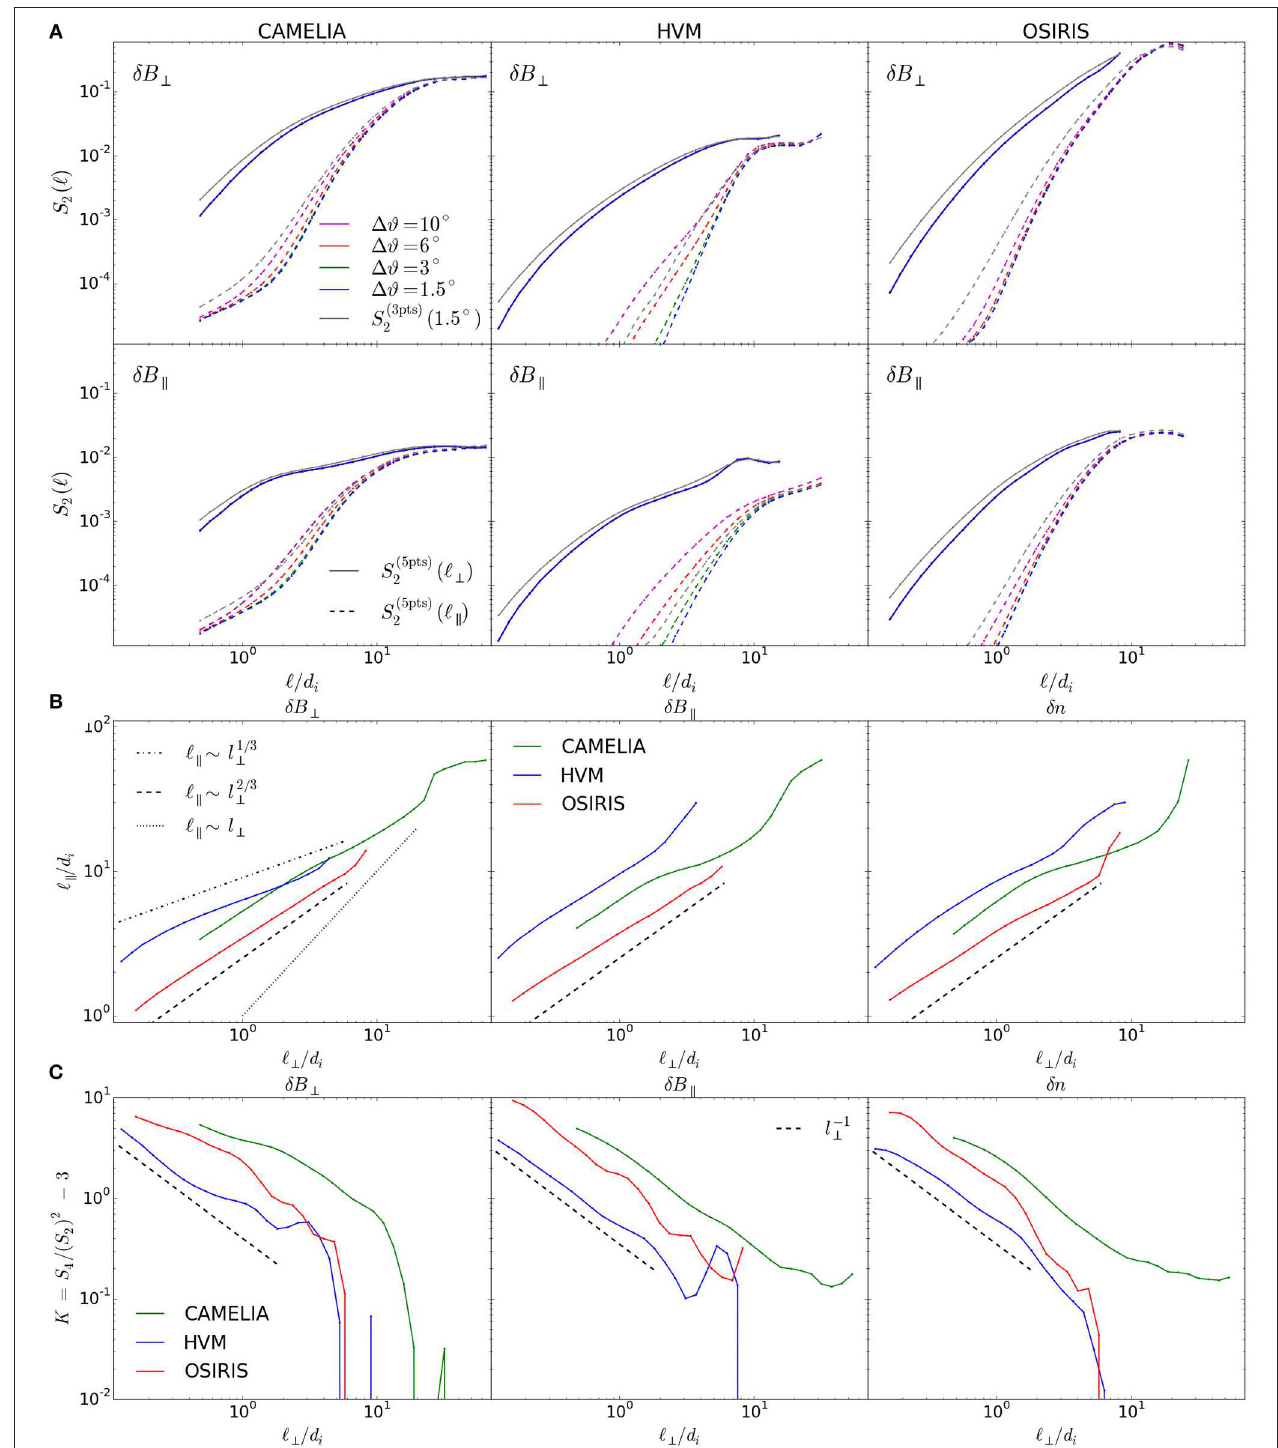
FIGURE 2 | (A) Five-points, 2nd-order structure functions, S (5) 2 , of δ B are defined with respect to the local field direction (i.e., δ B also shown for reference (gray lines). (B) Anisotropy scaling, ℓ nominal resolution. Three reference scalings are also shown. (C) Excess kurtosis, K A 1 /ℓ scaling is given for ⊥